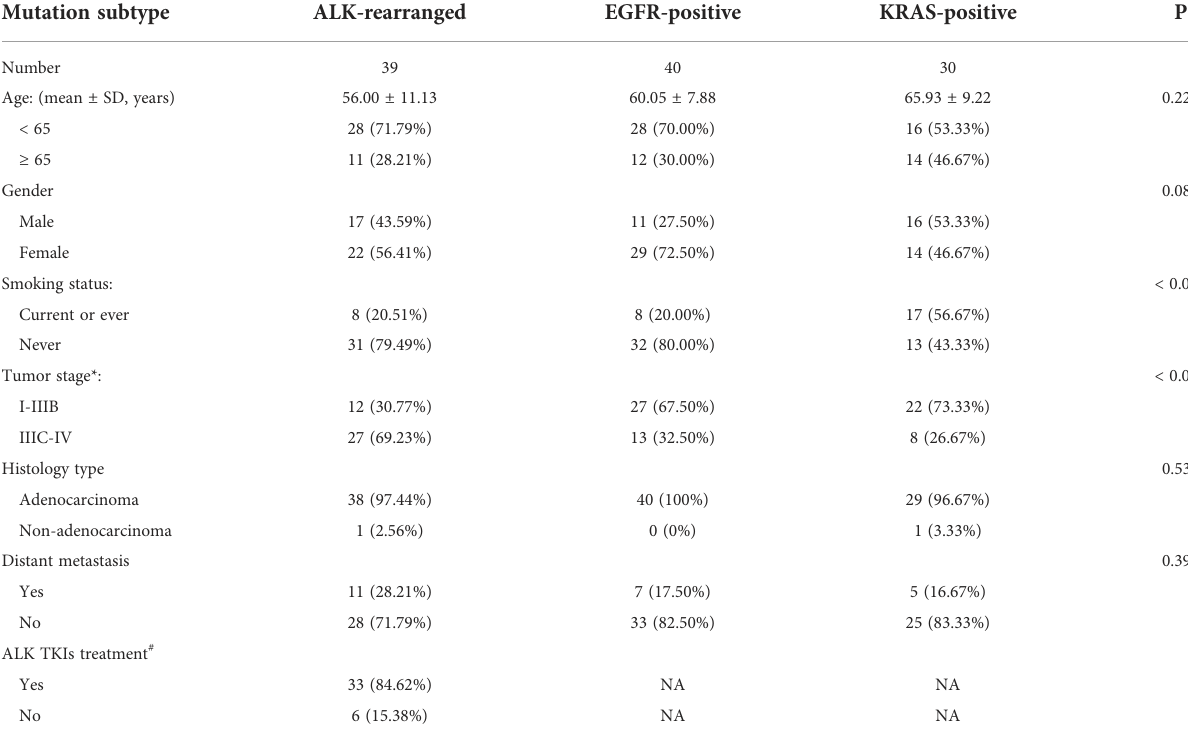
TABLE 1 Clinical and pathological characteristics of ALK-/EGFR-/KRAS-positive NSCLC. Mutation